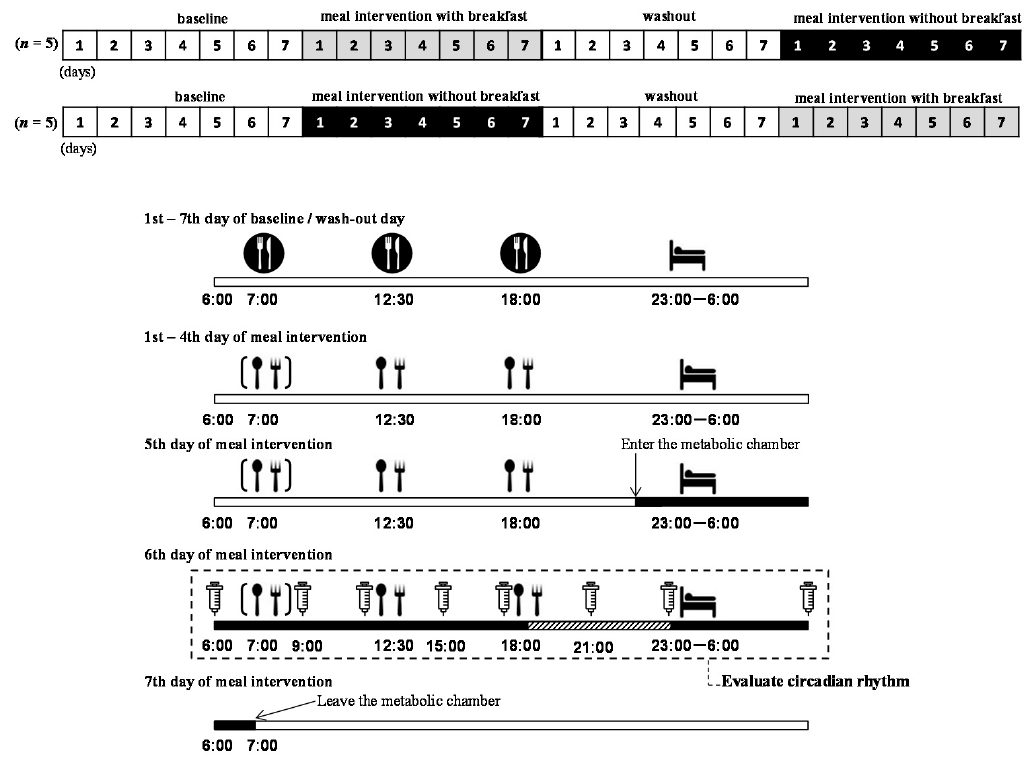
Figure 1. Study Figure 1. Study protocol.